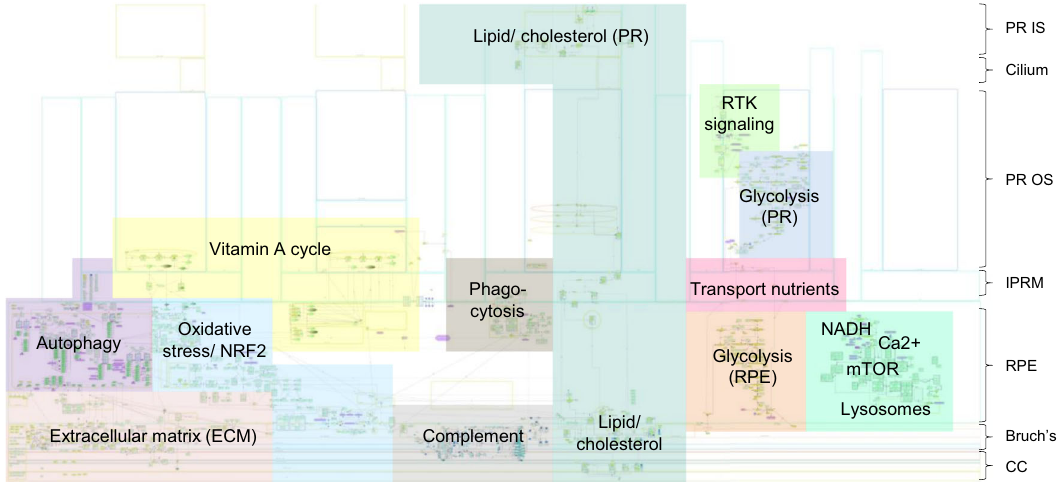
Fig. 2 Illustration of the full SBGN model of AMD pathogenesis. The pathway map was generated using CellDesigner. 22 For additional map details see Data Availability, Supplementary File 1 (can be viewed using CellDesigner